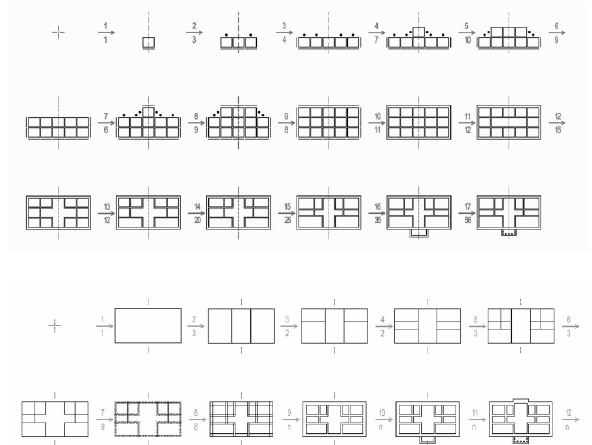
Figure 1. Villa generation: comparison between original and alternative